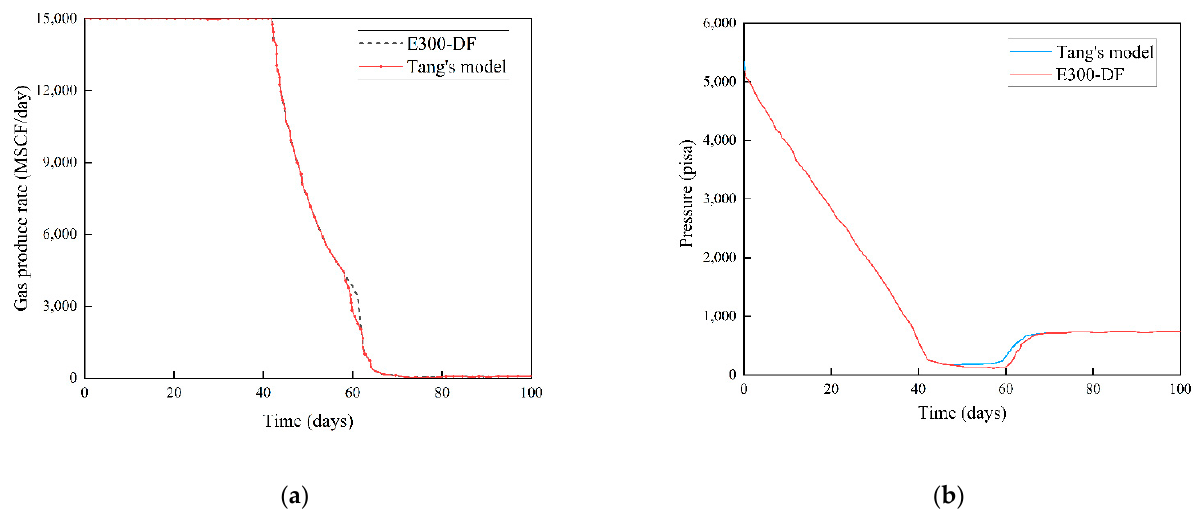
Figure 9. Comparisons of ( a ) gas-producing rate and ( b ) the pressure of a perforated segment from Tang et al.’s coupled reservoir/wellbore simulator and E300. This figure was modified from Figure 4.7 in ref [96]. 4.7 in ref